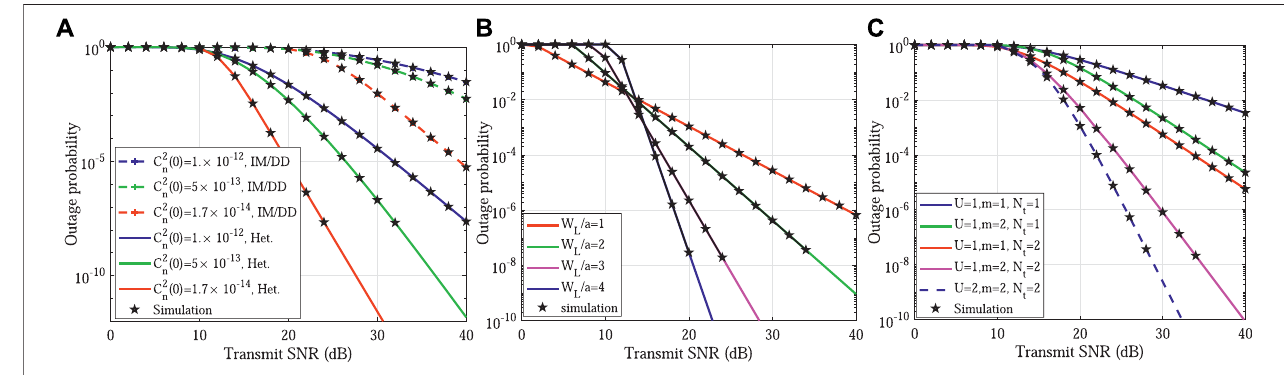
FIGURE 3 | Comparison of analytical and simulation results of individual link ’ s outage probability against transmit SNR for (A) ES-HAP link, (B) HAP-HAP link, and (C) HAP-MUs link.